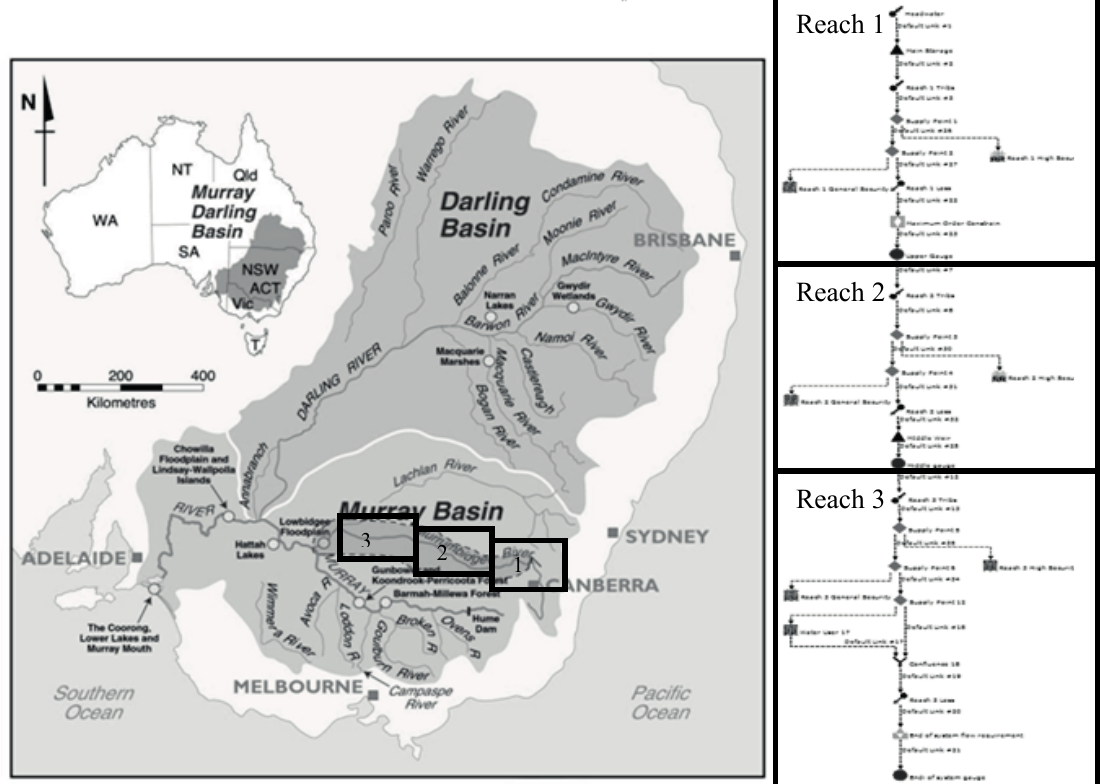
Fig. 2 Map showing the extent (indicated by shading) of the Murrumbidgee demonstration use case within the Murray-Darling Basin, and the conceptualisation of the river system into three